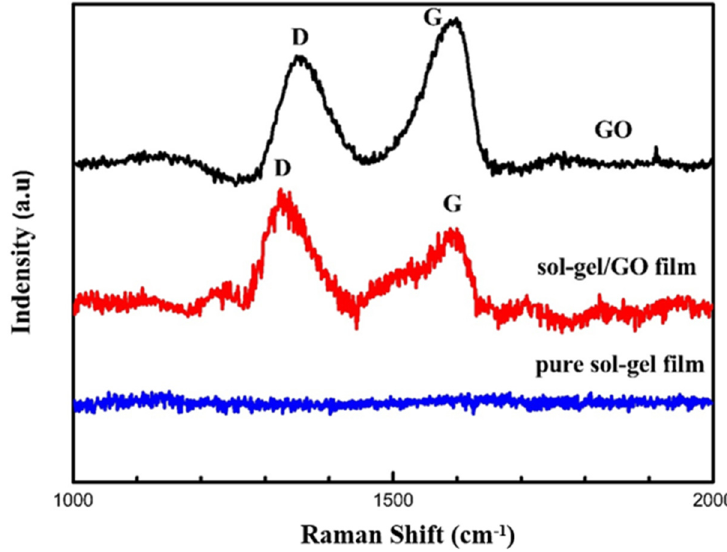
Figure 1. Raman spectra of GO, pure sol-gel film and sol-gel/GO fil.